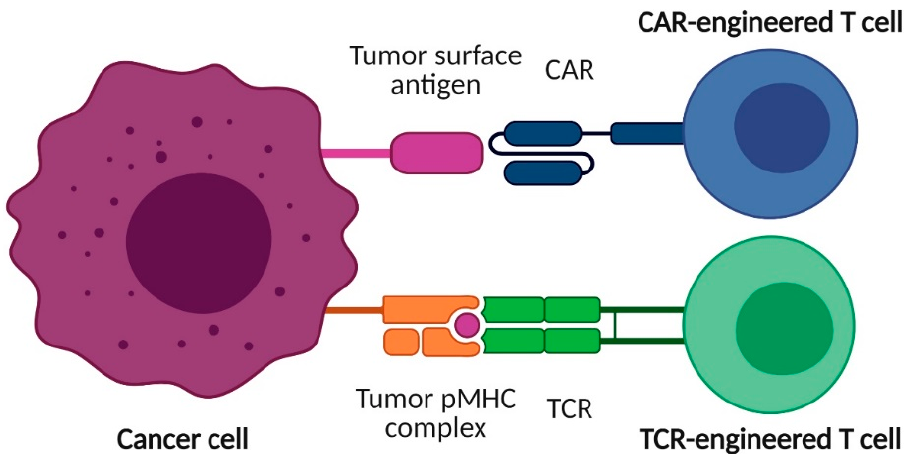
Figure 1. Chimeric antigen receptor (CAR) and T-cell receptor (TCR) engineered T cells. CAR-T cells usually target surface antigens, whereas TCR-T cells recognize internally processed proteins presented by molecules of the major histocompatibility complex (MHC) as peptide-MHC (pMHC) complexes. Each TCR is specific for a pMHC, allowing an infinite set of pMHC combinations that can be exploited for TCR-T-cell therapy. Created with BioRender.com (San Francisco, CA, USA).